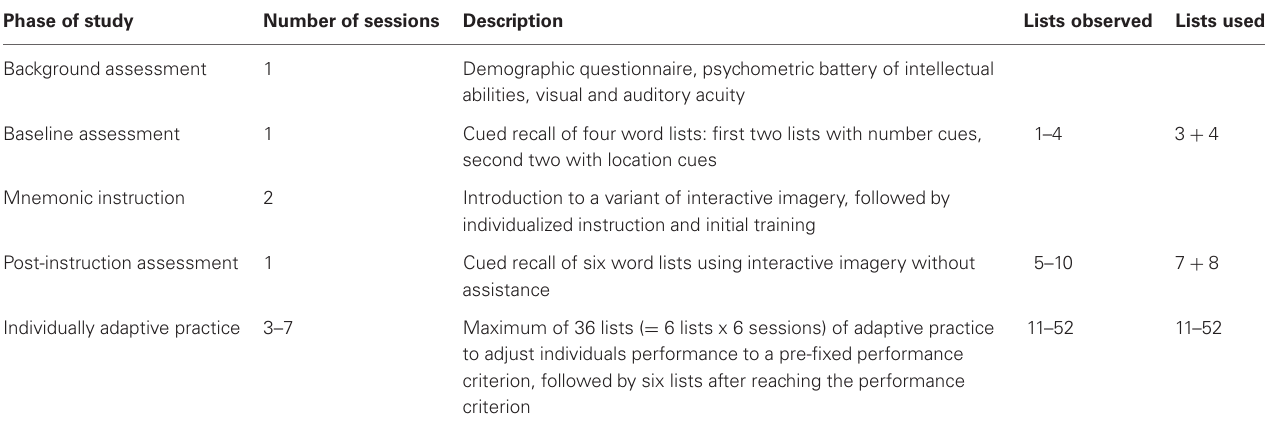
Table 2 | Outline of study